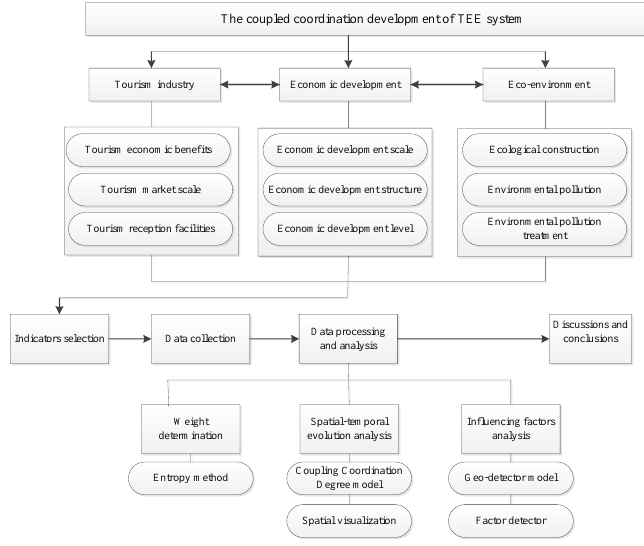
Figure 3. Research framework of the coupled coordination development of the TEE